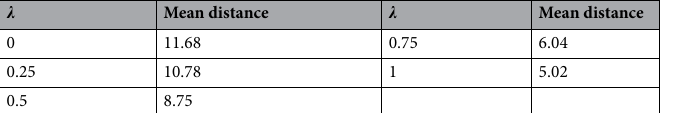
Table 2. Mean distance between the theoretical prediction in (4) and the mean curve we obtain from bootstrapping the observed angles (see Sect. A.3.3) for several pairs of parameters ( b , β) . In particular, we consider the combinations having b = − 10, − 3, − 1, 0, 1, 3, 10 and β = 0.01, 0.1, 1, 3, 4, 10, 100 .